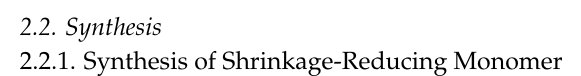
Table 1. Chemical and mineral compositions of reference